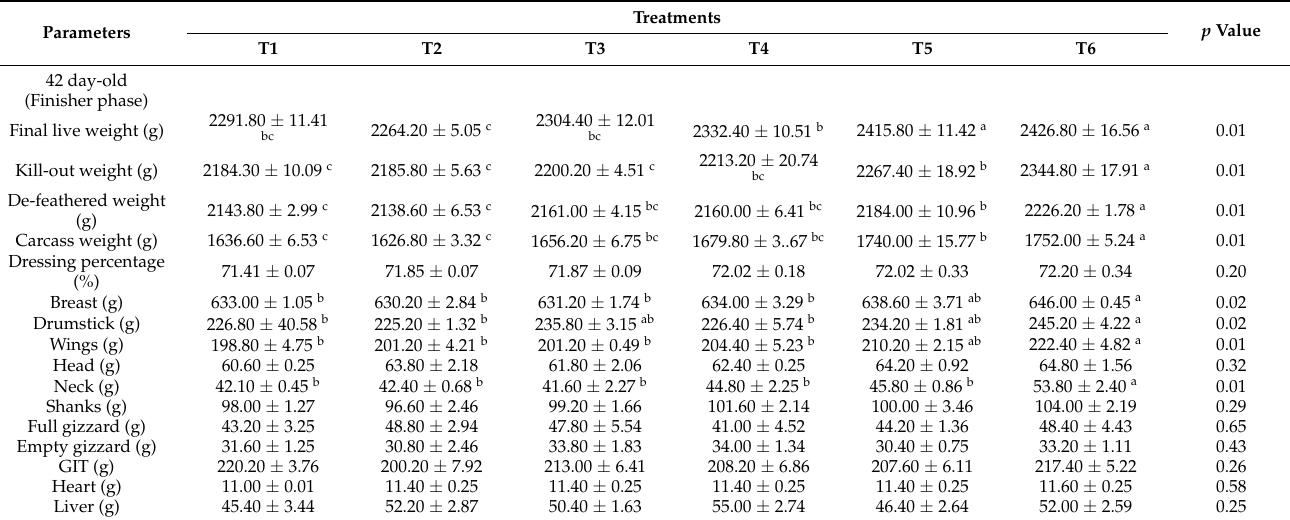
Table 7. Effect of Y. schidigera supplementation on the carcass characteristics of broilers on day